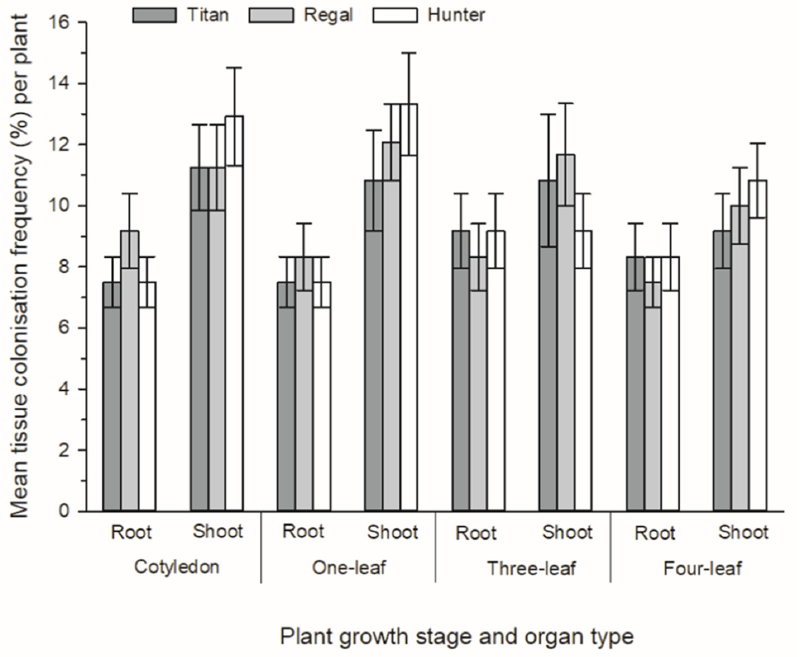
Figure 3. Tissue colonisation frequency (TCF%) of Beauveria bassiana O2380 within shoot and root tissues of three forage Brassica cultivars (rape, cv. Titan, kale, cv. Regal and a leafy turnip, cv. Hunter) at four plant growth stages (cotyledon, one-leaf, two-leaf and four-leaf). 3.3. Bioactivity of Fungal Endophytes towards Leptosphaeria Maculans